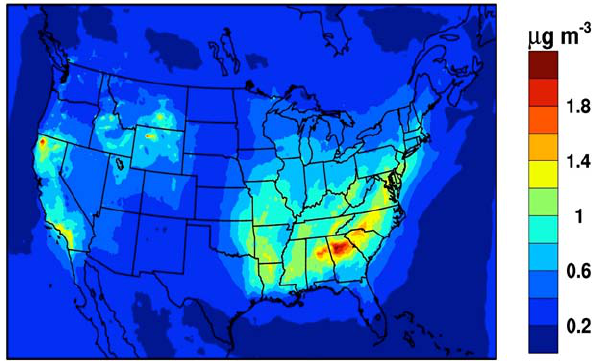
Fig. 7. Total SOA averaged over 15–31 July 2006 for the base case simulation (using default CMAQ